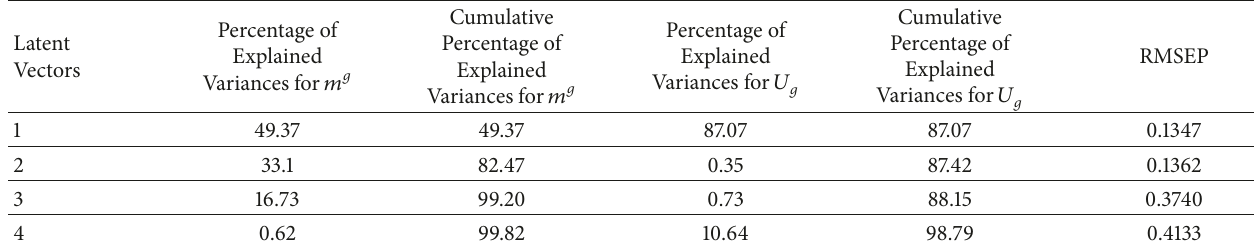
Table 7: Variance of 𝑚 𝑔 and 𝑈 𝑔 explained by the latent vectors and RMSEP for Egypt. Latent Vectors